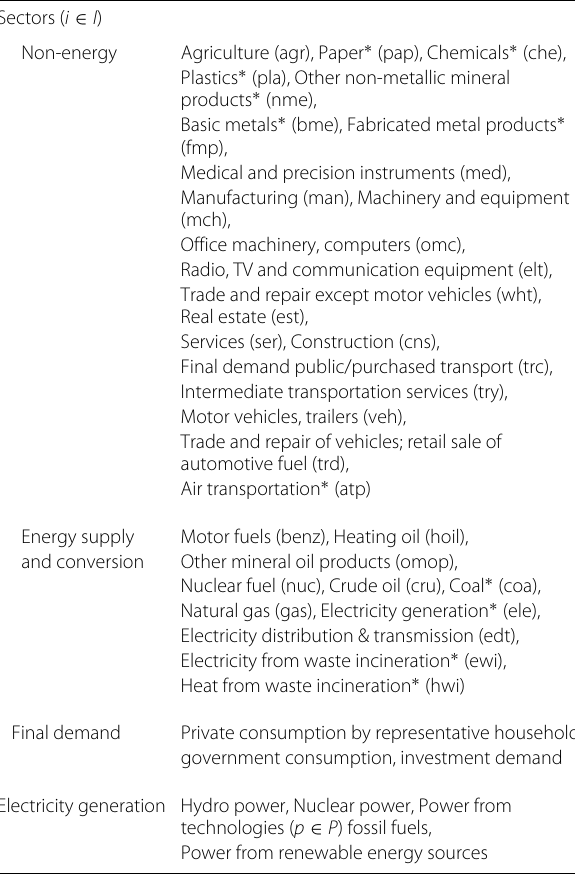
Table 1 Overview of model resolution: sectors, electricity generation technologies, and household groups Sectors ( i ∈ I )